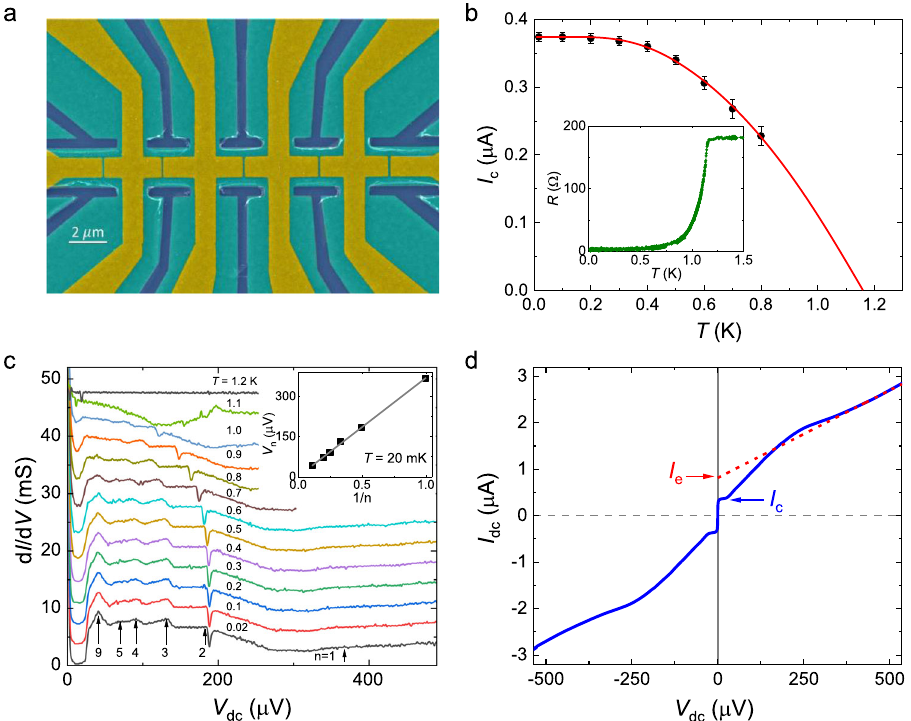
Fig. 2 Properties of the Pd-BST/BST/Pd-BST sandwich-type Josephson junction. a False-color SEM image of the wafer including device 1 (2nd left junction); Pd electrodes (dark-yellow), BST fi lm (turquoise), and sapphire substrate (dark-blue) are visible. The fi ve junctions pictured here were fabricated with the Pd gap ranging from 100 to 150 nm (from left to right). b T dependence of the critical current I c of device 1 with a theoretical fi t (red solid line), where the error bars are the larger of (i) the amplitude of the ac excitation current (±5 nA) or (ii) HWFM of the peak in d V /d I vs. I dc at the breakdown of superconductivity; inset shows the T dependence of the junction resistance measured with a quasi-four-terminal con fi guration. c dI / dV as a function of the dc bias voltage V dc at various T ; the curves are successively offset by 3.5 mS, except for the 20-mK data. Black arrows mark the MAR peaks with index n . Inset: The voltage corresponding to the MAR peaks, V n , plotted vs. 1/ n . d I – V characteristics at 20 mK in 0 T. A fi t to the linear region at high bias (red dashed line) gives the excess current I e and the normal-state resistance R N . Also, the I c R N product can be obtained from these (Fig. 2c inset), which is the key signature of MAR. From the slope of this linear fi t, we obtain the superconducting gap Δ SC = 184 μ eV.